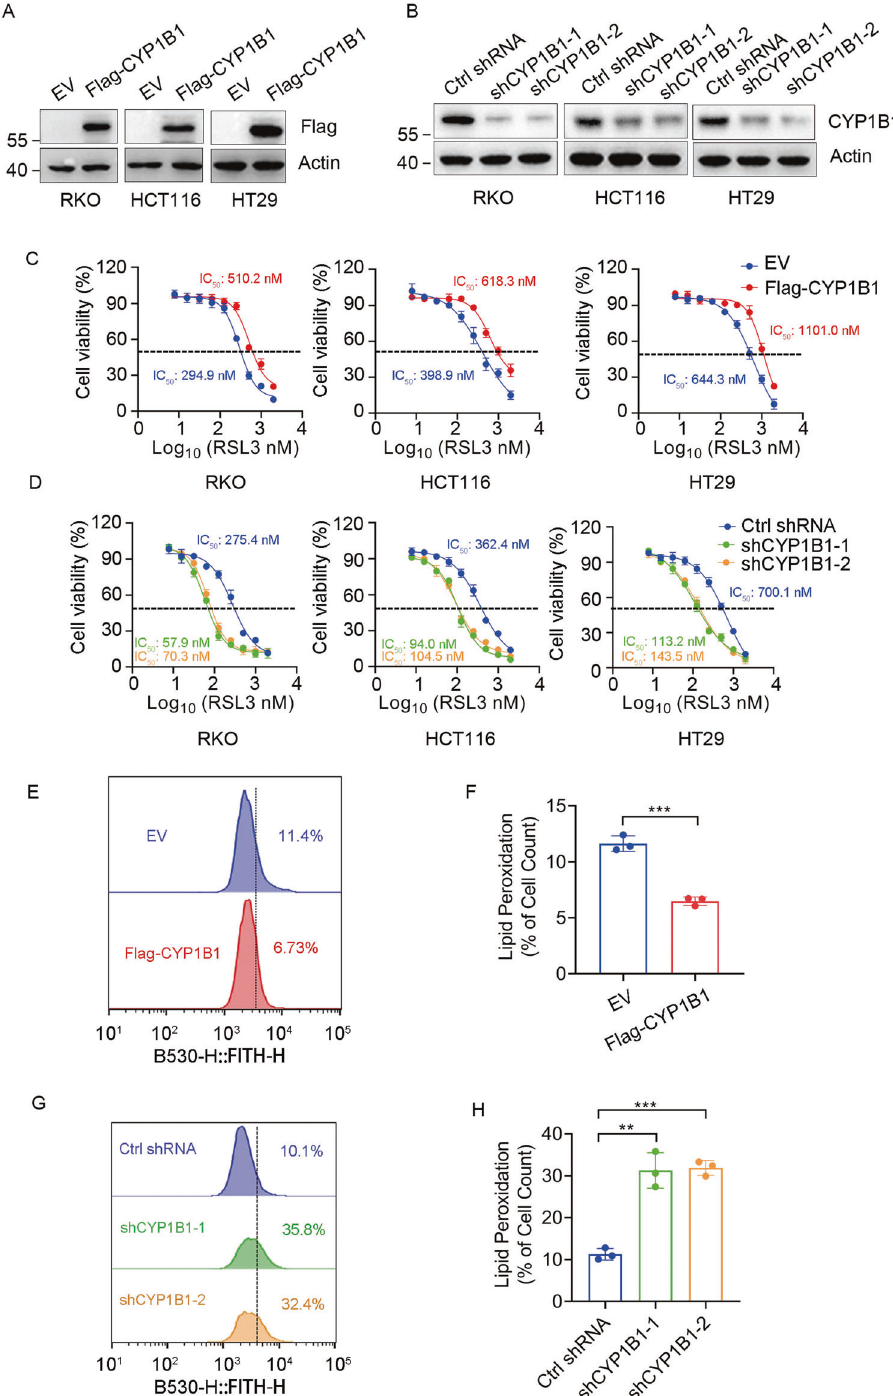
Fig. 1 CYP1B1 is involved in ferroptosis. A Western blot analysis of RKO, HCT116 and HT29 cells expressing empty vector (EV) or Flag- CYP1B1. B Western blot analysis of RKO, HCT116, and HT29 cells expressing control (ctrl) shRNA or CYP1B1 shRNA. C , D Viability curves of RKO, HCT116 and HT29 cells with CYP1B1 overexpression or knockdown treated with the indicated concentrations of RSL3. E – H Lipid peroxidation levels were tested using C11-BODIPY in CYP1B1 overexpression ( E , F ) or knockdown ( G , H ) RKO cells. The data shown represents the mean ± SD; n = 3. p value was determined by Student ’ s two-sided t test. ** p < 0.01, *** p < 0.001. ACSL4. As expected, we found that CYP1B1 overexpression increased poly-ubiquitin chain linked-ACSL4 (Fig. 2H), whereas CYP1B1 knockdown reduced the polyubiquitination level of ACSL4 (Fig. 2I). These results suggest that CYP1B1 promoted ACSL4 degradation by increasing ACSL4 ubiquitination.